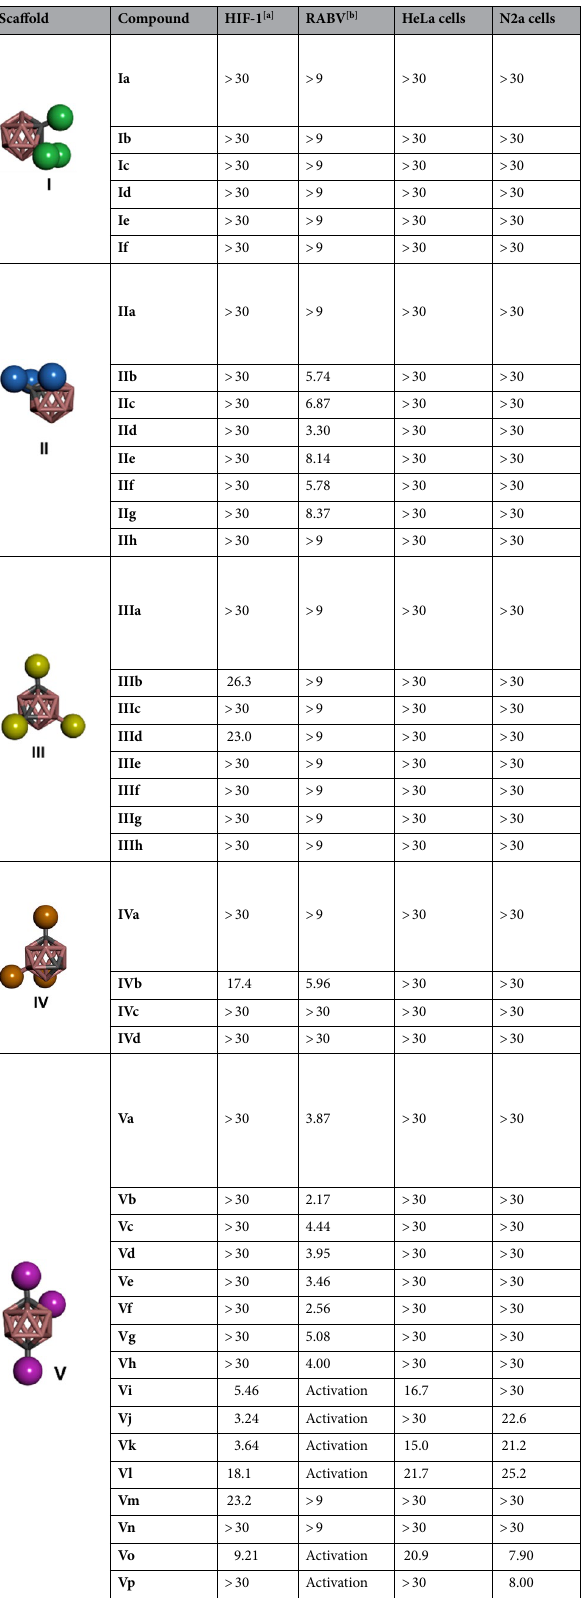
Table 1. Results of the evaluation of the biological activities of various members of the trisubstituted carborane compound library. The compound concentration required to inhibit the relative light units by 50% (IC 50 ) was determined based on semi-logarithmic dose–response plots. All the samples were tested in triplicate. [a] YC-1 was used as positive control with IC50 of 0.17 µM. [b] Favipiravir was used as a control with IC 50 of 38